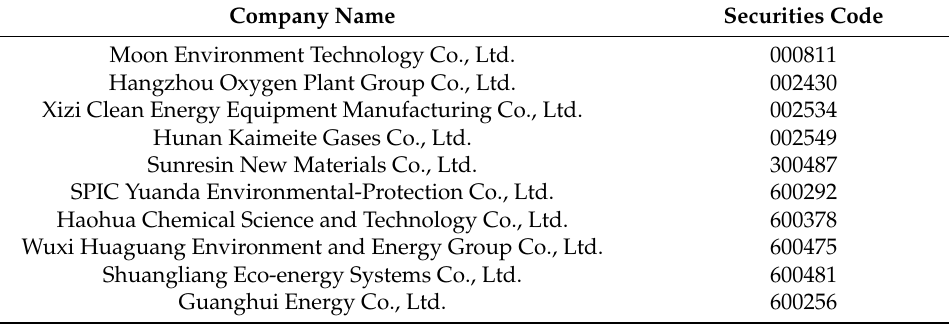
Table 1. Panel data sample of carbon capture technology listed companies. Company